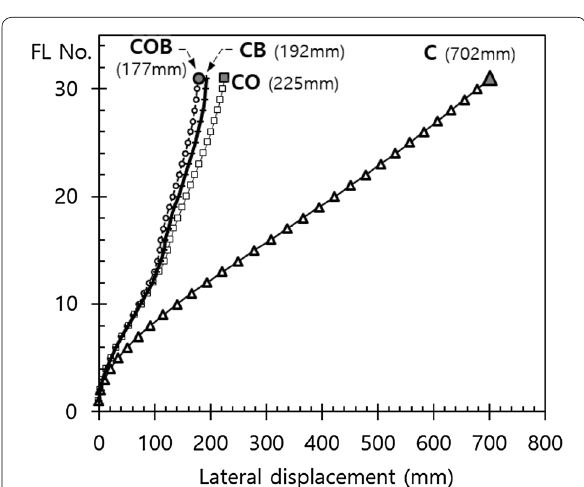
Fig. 4 Lateral displacements of conventional structure systems obtained by elastic analysis for W x